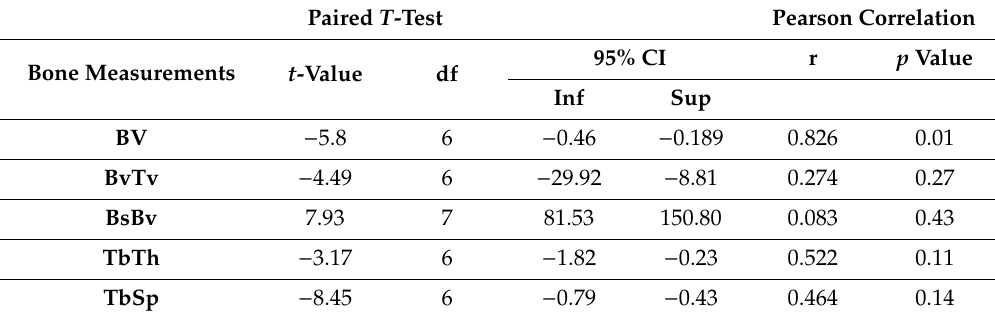
Table 3. Statistical analysis. Paired T -Test Pearson